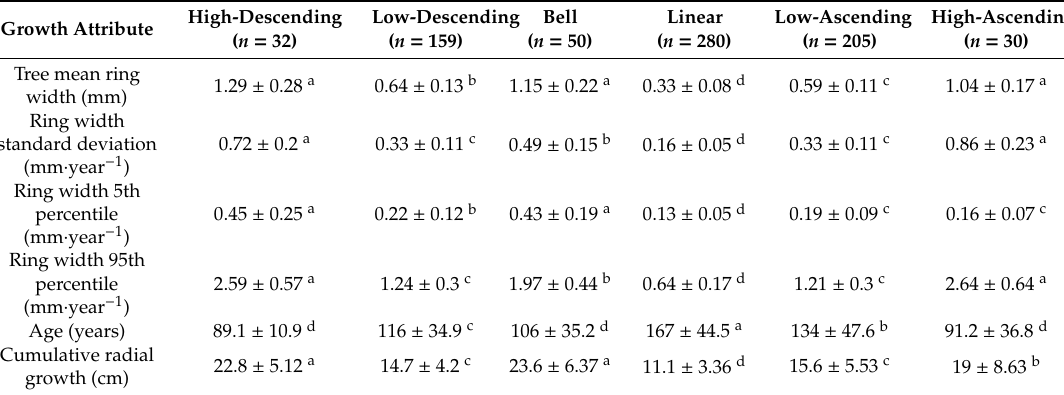
Table 2. Mean and standard error of the growth attributes for each growth